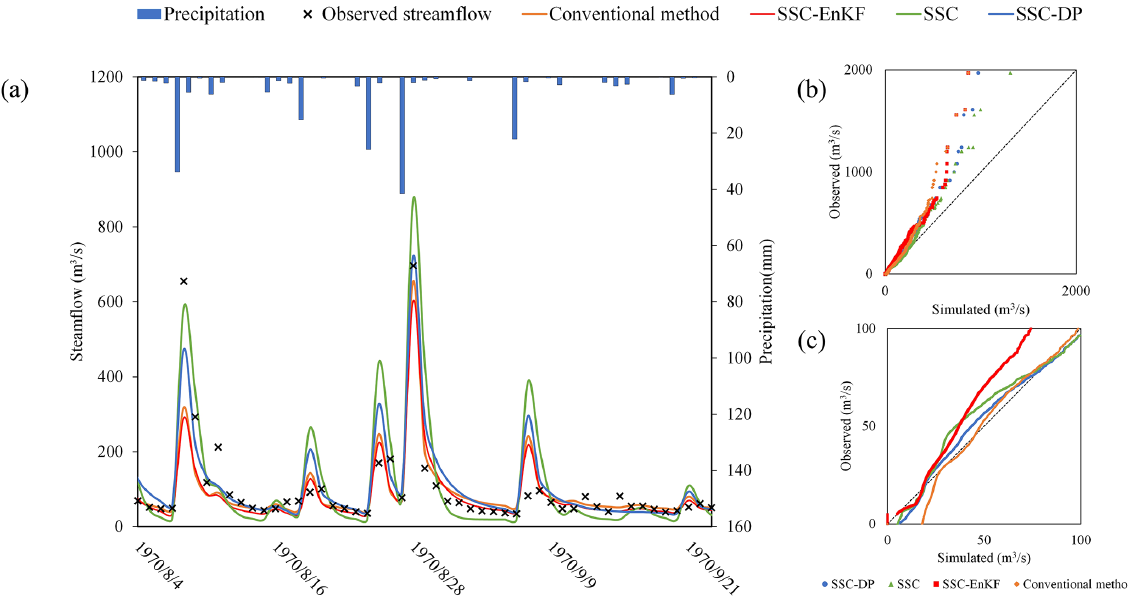
Figure 13. The simulated and observed streamflow using the conventional method, SSC-EnKF, SSC, and SSC-DP for the Wuding River basin. (a) Streamflow simulation hydrograph. (b) The quantile–quantile plot for all streamflow. (c) The quantile–quantile plot for streamflow lower than 100m 3 s − 1 .